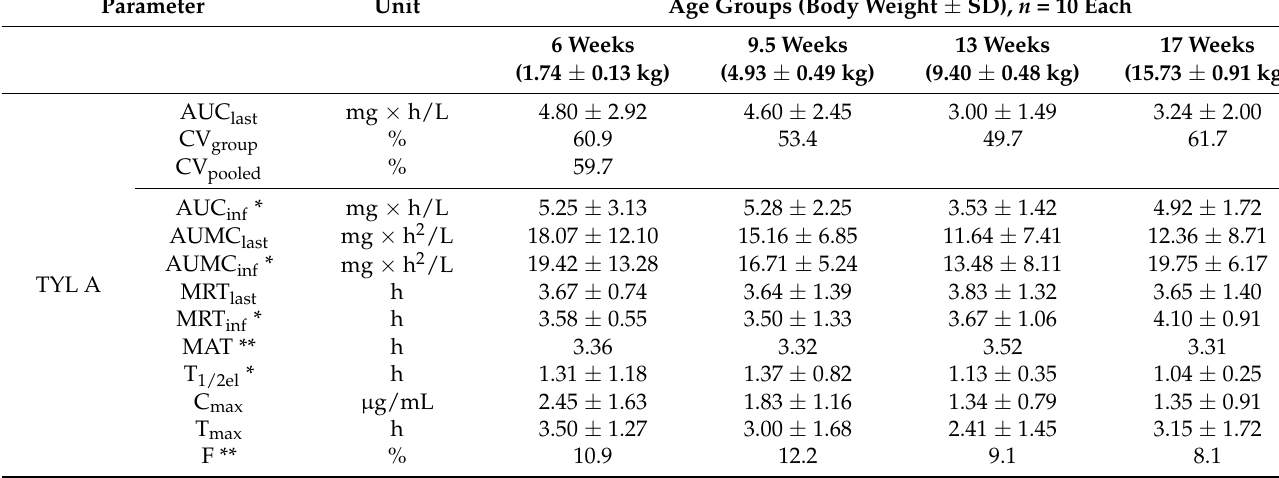
Table 2. Pharmacokinetic parameters after single oral tylosin tartrate administration to turkeys dosed according to the protocol: Dose = 158 × BW 0.58